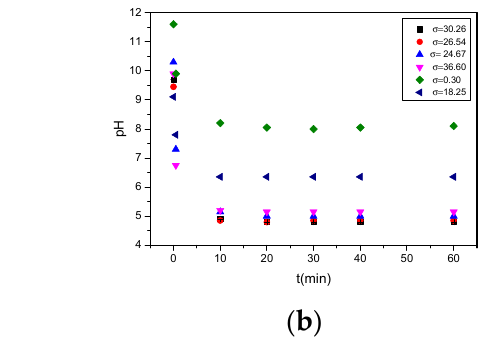
25 ° C. Error bars are included but they are too small to show o ff . 25 ◦ C. Error bars are included but they are too small to show